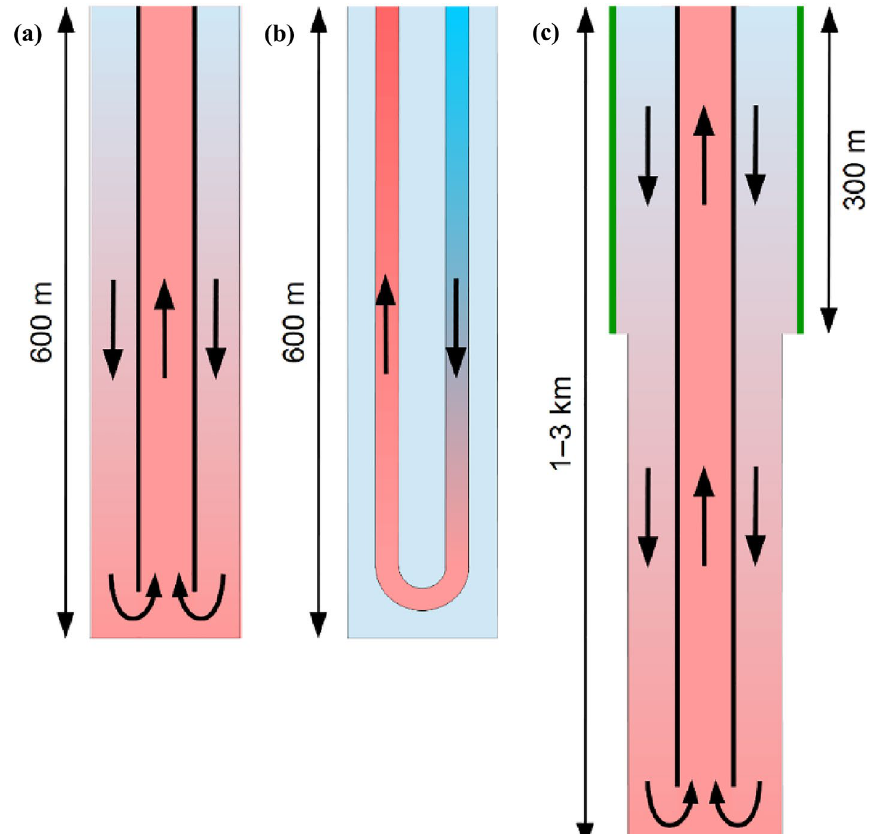
Fig. 2 The borehole heat exchangers modelled in this study. a A 600-m-deep open-loop coaxial borehole heat exchanger, b a 600-m-deep U-tube borehole heat exchanger, and c a 1- to 3-km-deep open-loop coaxial borehole heat exchanger with casing in the topmost 300 m (green). Arrows indicate the direction of working fluid